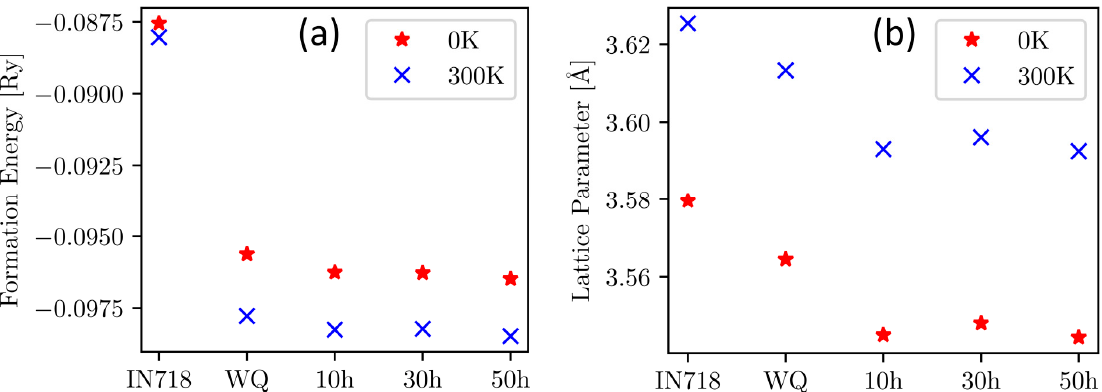
Figure 9. Comparison of calculated material properties for the matrix composition of IN718 from literature ([20]) and the matrix phase of the actual CCA right after water quenching (WQ) and after 10 h, 30 h, and 50 h of aging at 0 K and 300 K. ( a ) Shows the formation free energies, ( b ) the equilibrium lattice constants.